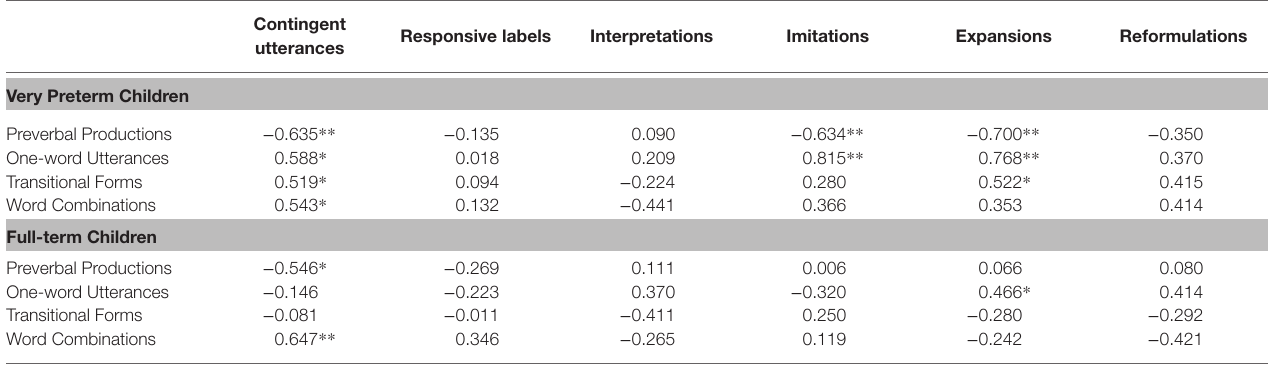
TABLE 3 | Results of Spearman correlation performed between speech input measures and children’s speech measures for the very preterm and the full-term group. Contingent